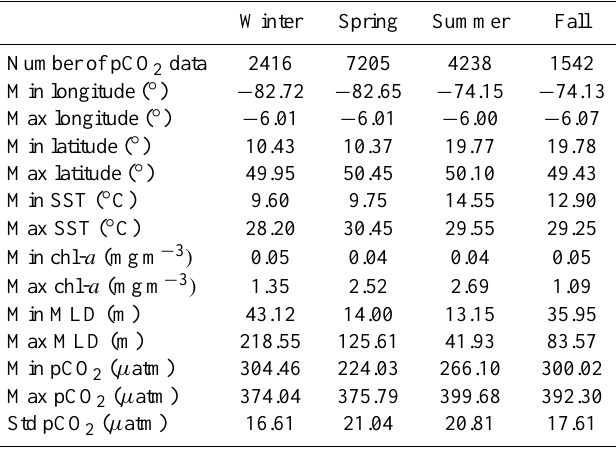
Table 1. Number of pCO 2 data per month, maximum and maximum of the longitude, latitude, SST, CHL and MLD for the paths of the cruises for the period June 1994–August